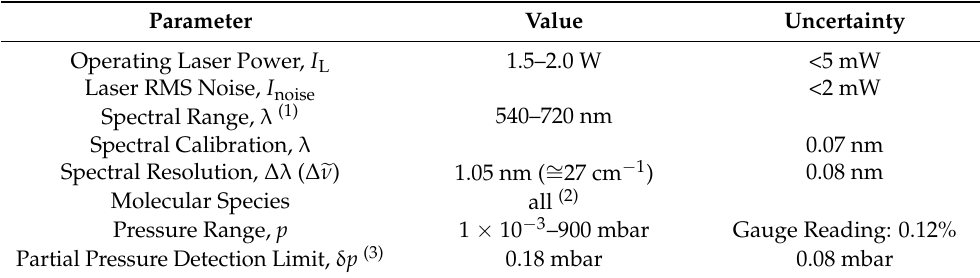
Table 2. Summary of key operating parameters and performance data for the LARA monitoring